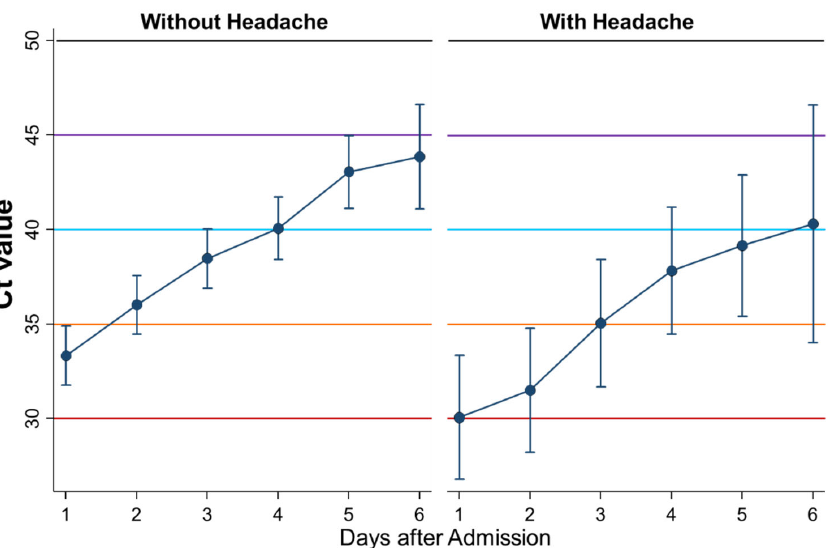
Figure 8. Differential kinetics of Ct values between patients without headache and with headache. Mean Ct with 95% confidence intervals. When the Ct value is 40 or more, the PCR test result is considered negative.